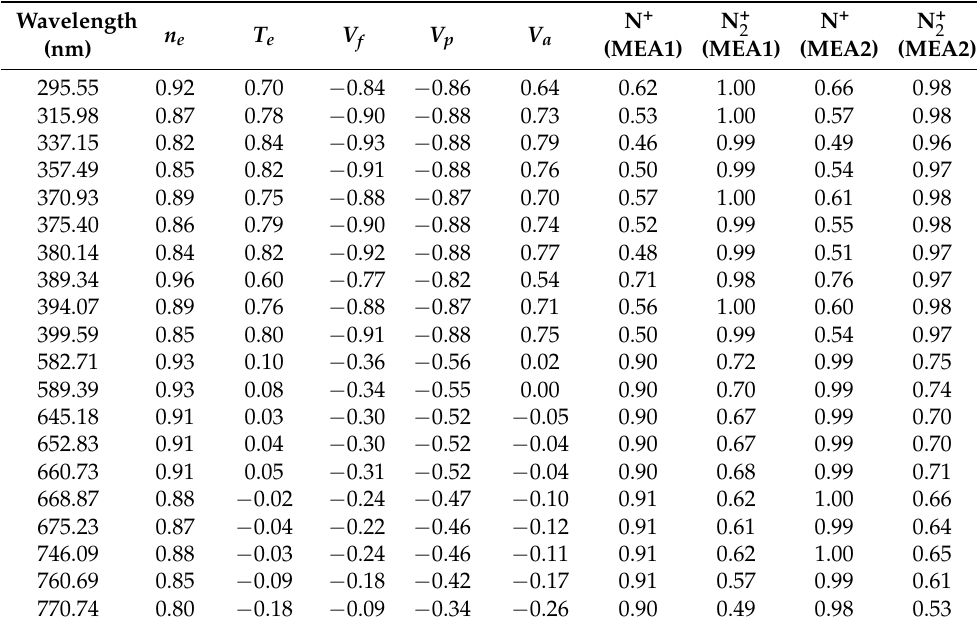
Table 3. Pearson correlation coefficient R value between OES intensity at 20 wavelengths and plasma